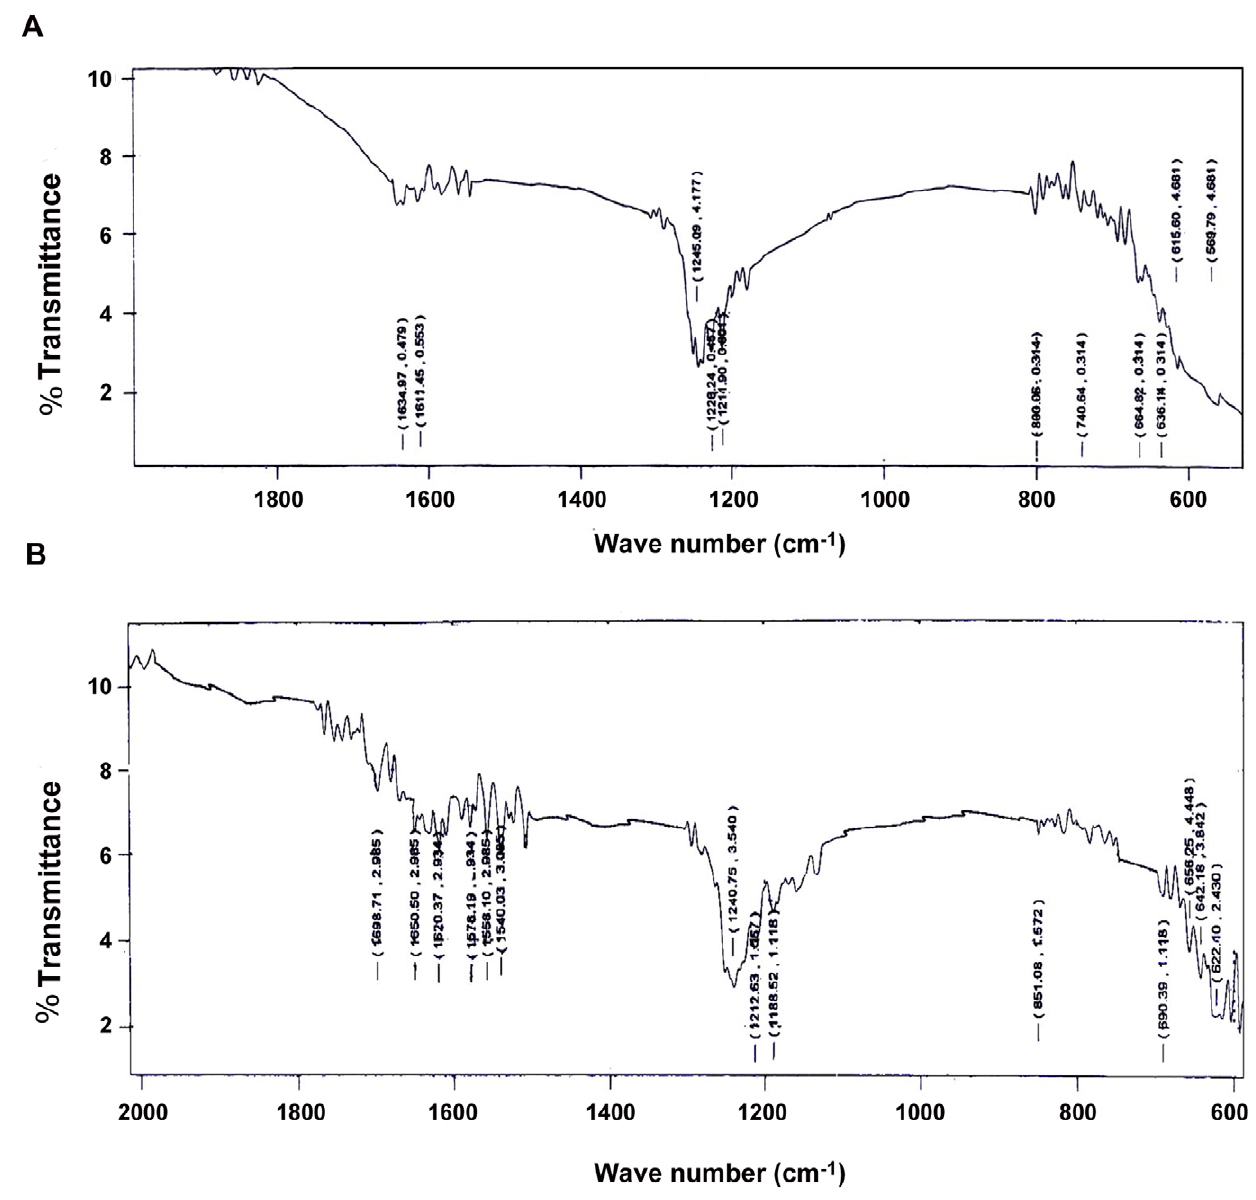
Figure 6. FTIR of CP-RF combination with and without photoillumination. Showing infrared spectra of CP-RF combination in presence and absence of photoillumination taking wave number (cm 2 1 ) and % transmission (%T) at X and Y-axes respectively. (A) FTIR spectra of CP-RF combination without incubation under light. (B) FTIR spectra of CP-RF combination after I hour of incubation under light.